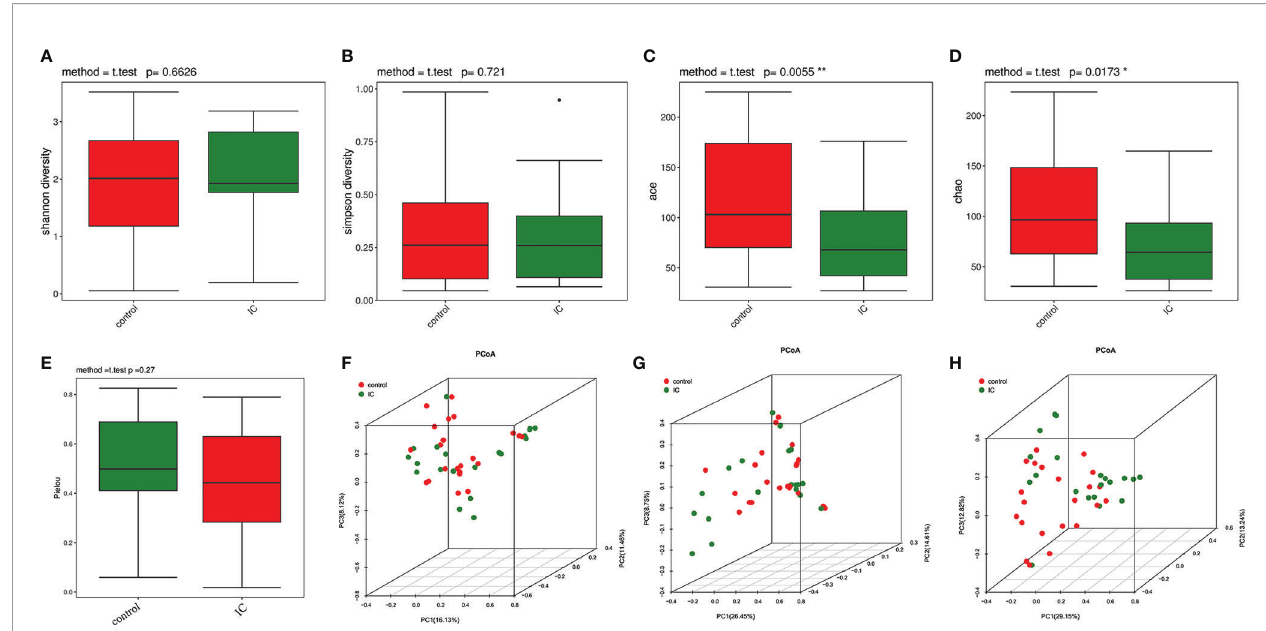
FIGURE 1 | Alpha diversity and principal coordinate analysis for control and IC urinary microbiomes. Shannon index (A) ; Simpson index (B) ; ace index (C) ; Chao1 index (D) ; Pielou index (E) . Principal coordinate analysis plot of the urinary microbiome based on the Bray Curtis distance (F) , unweighted UniFrac distance (G) , and weighted UniFrac distance (H) . *p < 0.05; **p <